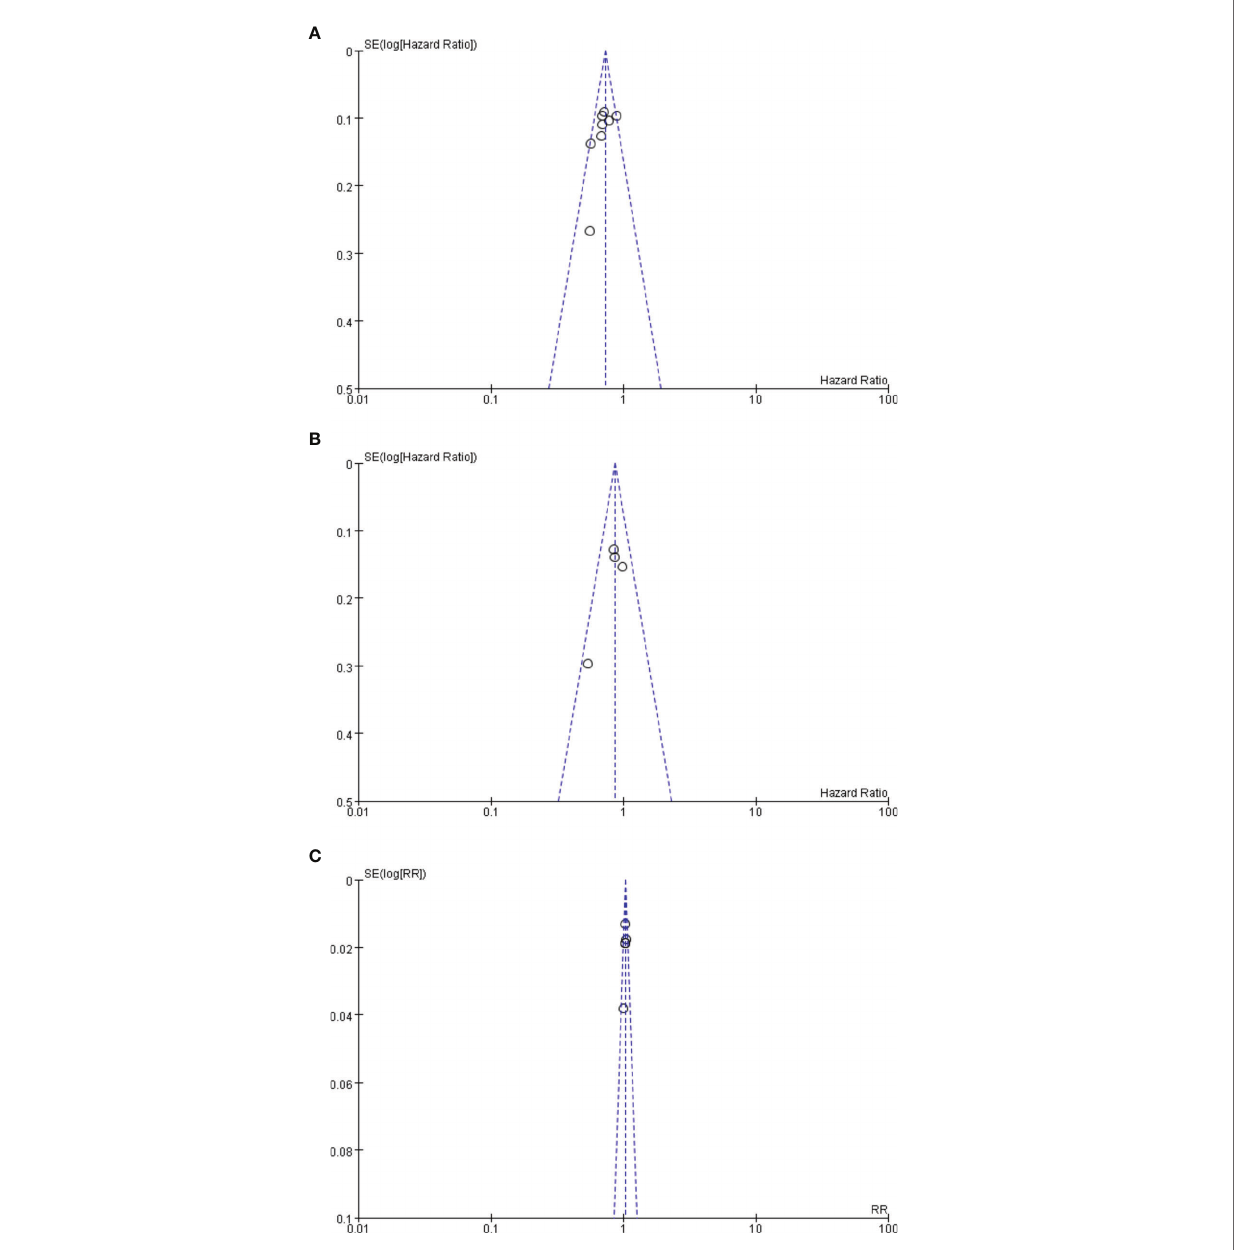
FIGURE 7 | (A) Funnel plot analysis of potential publication bias for RFS. (B) Funnel plot analysis of potential publication bias for OS. (C) Funnel plot analysis of potential publication bias for any advent